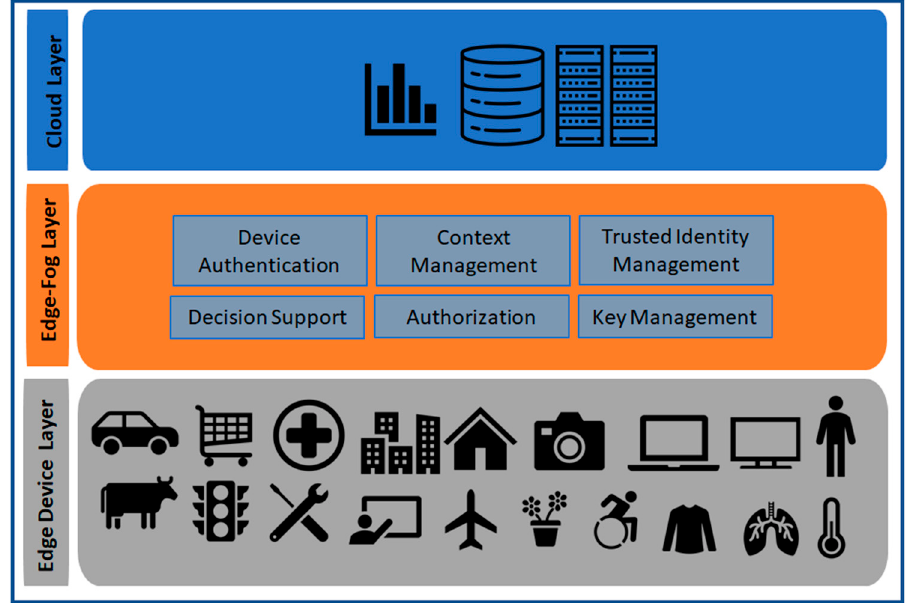
Figure 3. IoT trust management at edge-fog layer (adapted from reference [9]).